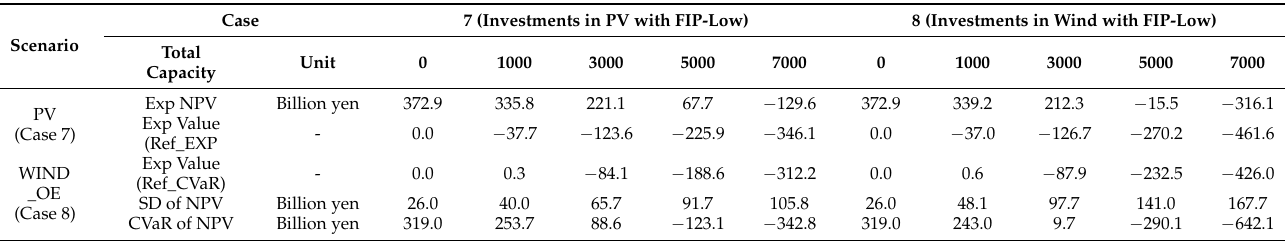
Table A5. Calculation results of Cases 7 and 8 (corresponding to Figure